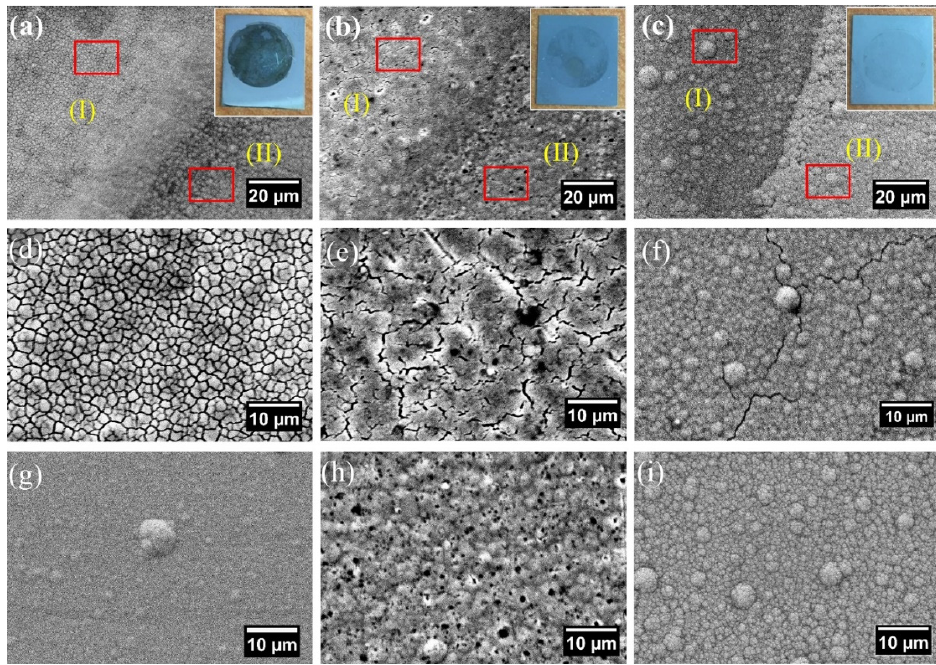
Figure 8. SEM images of corroded surface (region I) and original surface (region II) of ( a ) Ni-P, ( b ) Ni-P-SN, and ( c ) Ni-P-nSN coatings. The magnified view of corroded surfaces indicated by ‘I’ in ( a – c ) are shown in ( d , e , f ), respectively. Similarly, the magnified view of the original surfaces indicated by ‘II’ in ( a – c ) are shown in ( g , h , i ), respectively. The insets in ( a – c ) show the damaged circular regions of the coating specimens after the corrosion tests.